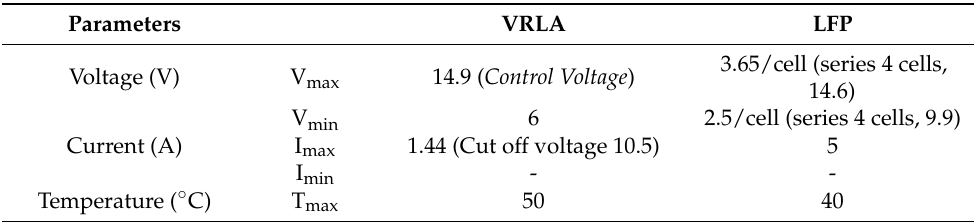
Table 1. Critical limits of Dual Battery Valve Regulated Lead Acid (VRLA) and Lithium Ferro Phosphate (LFP)